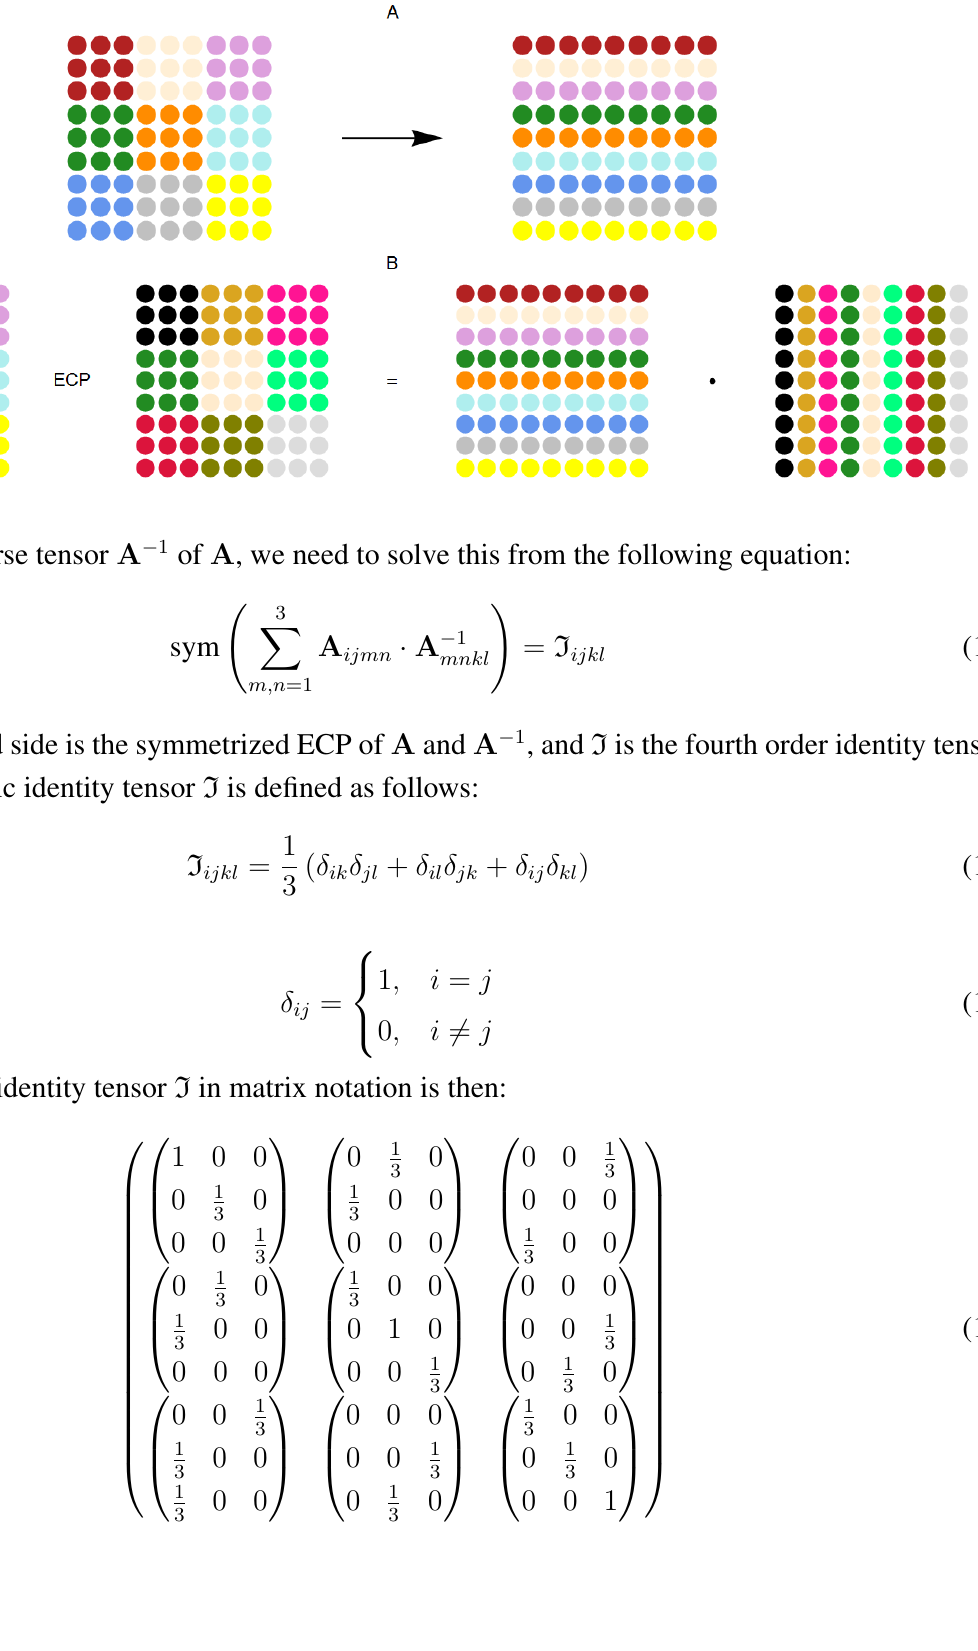
Figure 2. ( A ) An illustration of how the nested matrix should be reshaped to replace the Einstein contracted product (ECP) with an ordinary matrix product; ( B ) the correspondence between ECP and the matrix dot product after manipulating the tensor